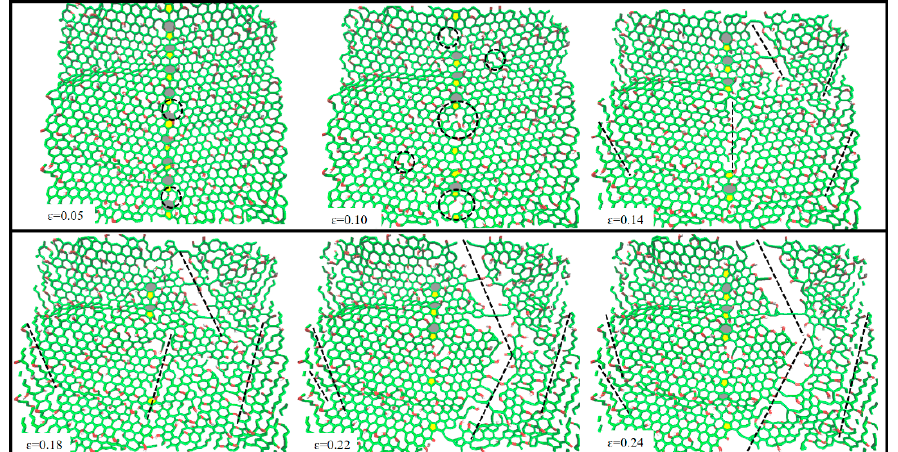
Figure 5. Tensile failure process of polycrystalline graphene oxide.